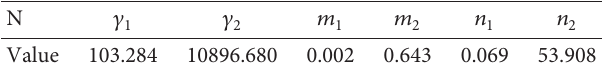
Table 4: The values of parameters of the threshold stiffness of dimensionless torsional bracing (equation (18)).